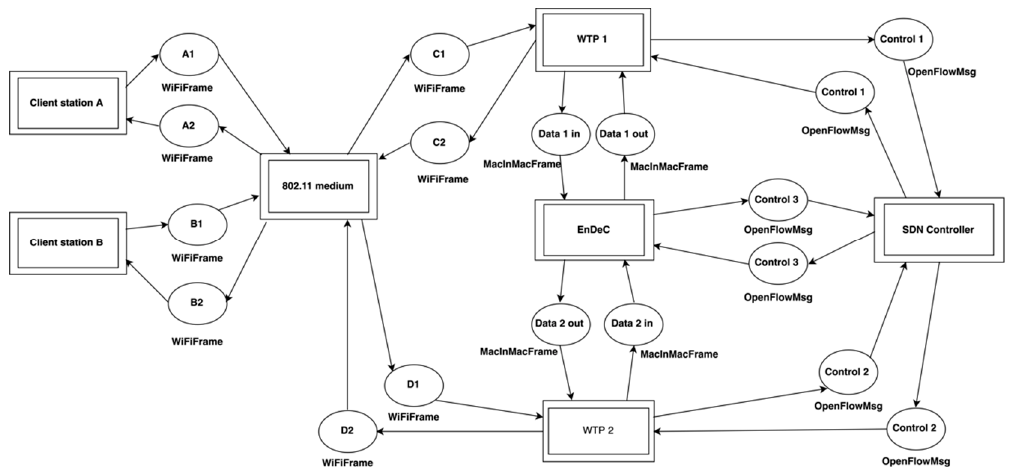
Figure 6. Interconnections of architecture components in Petri nets.